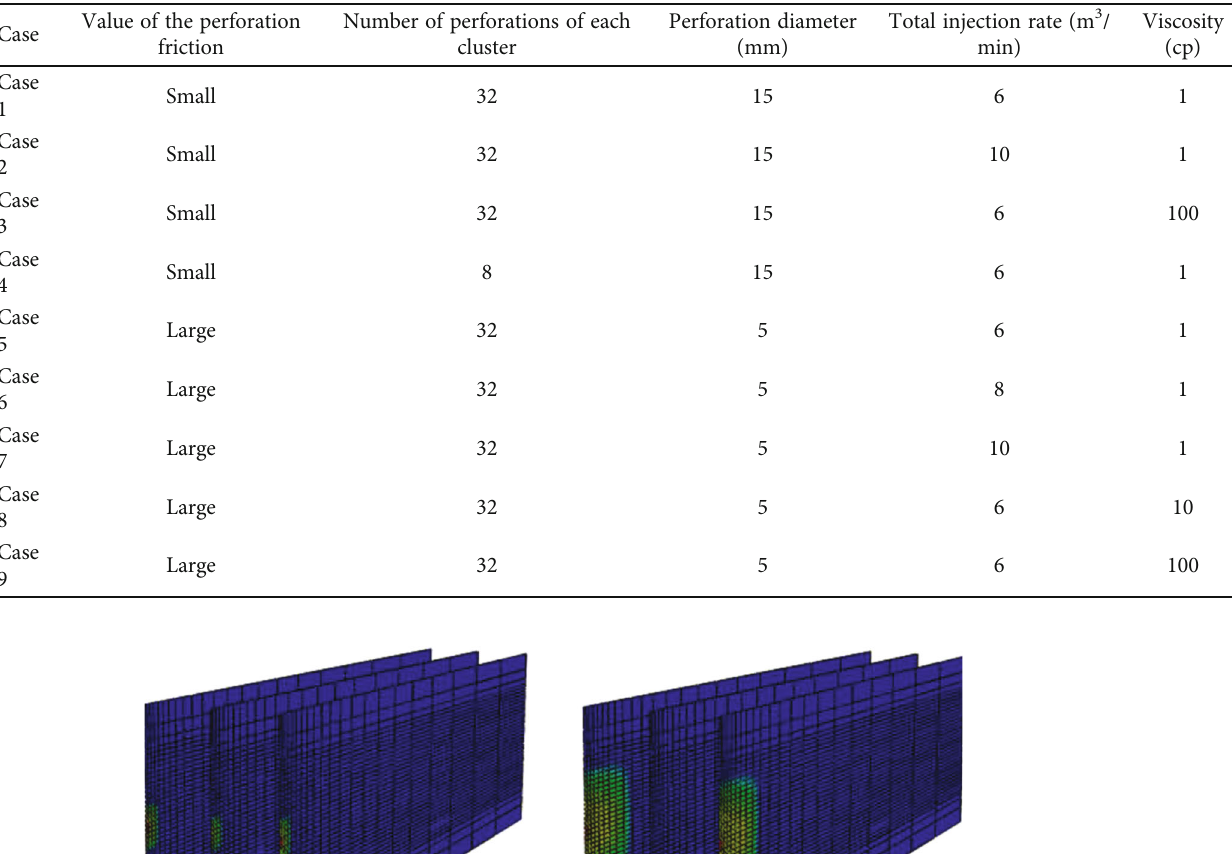
Table 3: Hydraulic fracturing design parameters in di ff erent cases.